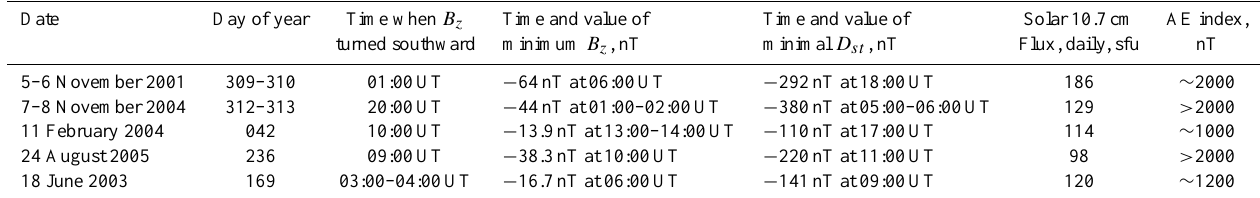
Table 2. Values of D st , B z , F10.7 and AE during the geomagnetic